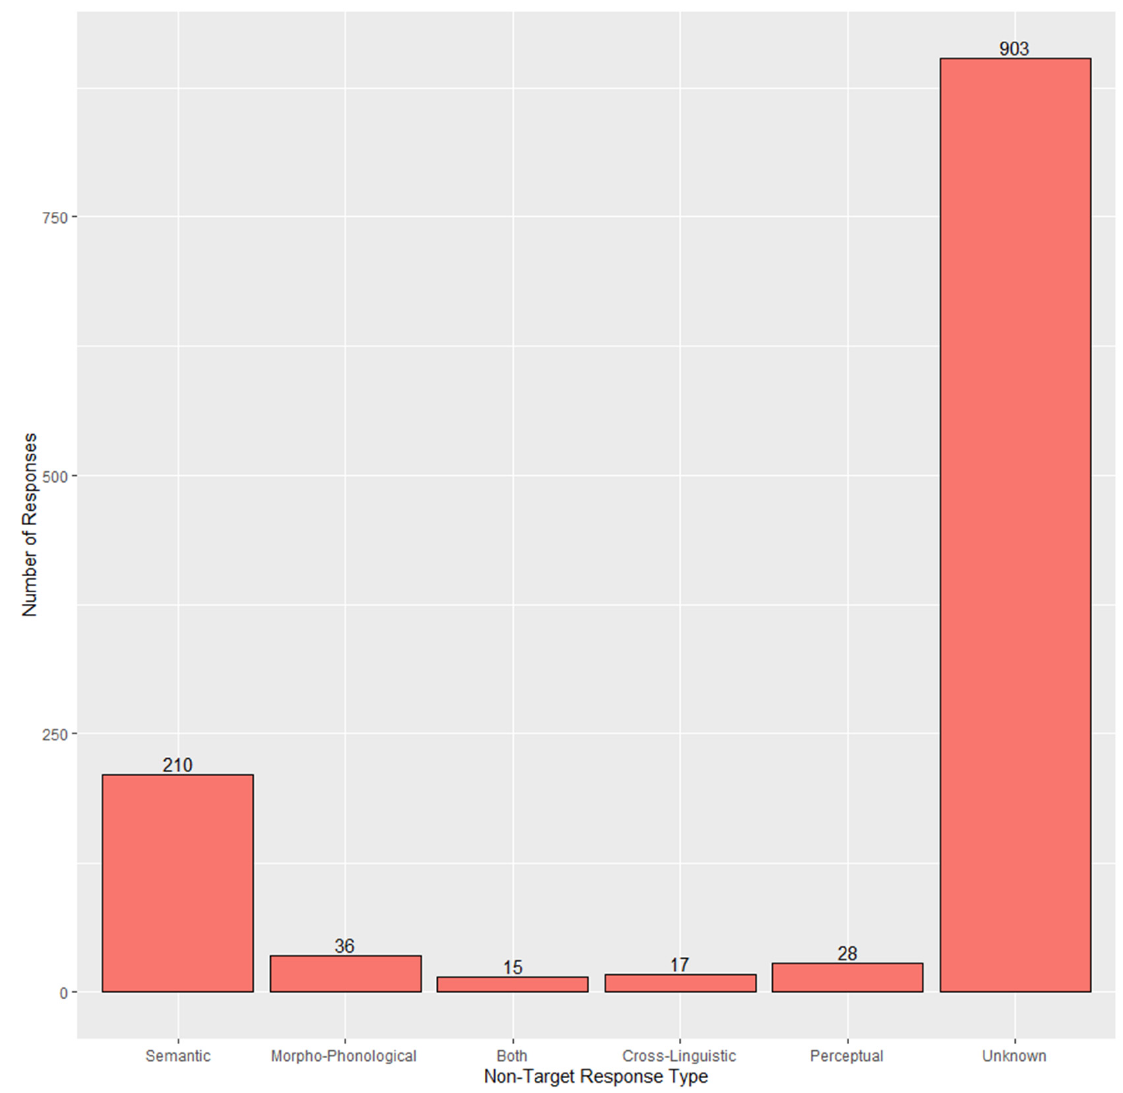
Figure 2. Non-target Response Types.